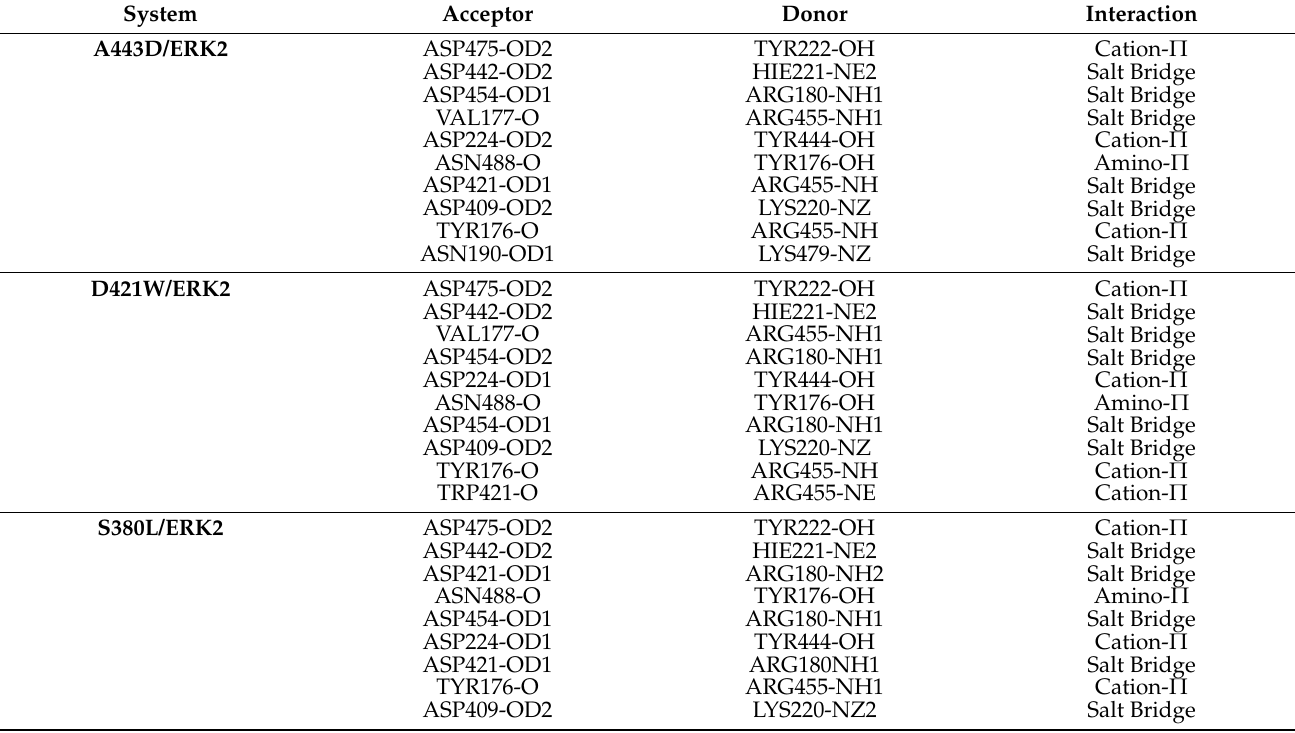
Table 5. Type of receptor-ligand interactions in mutant